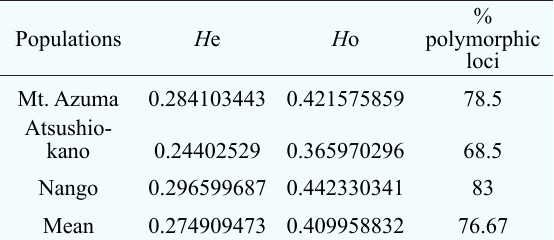
Table 4. Summary of analysis of molecular variance for the three populations of Lilium rubellum